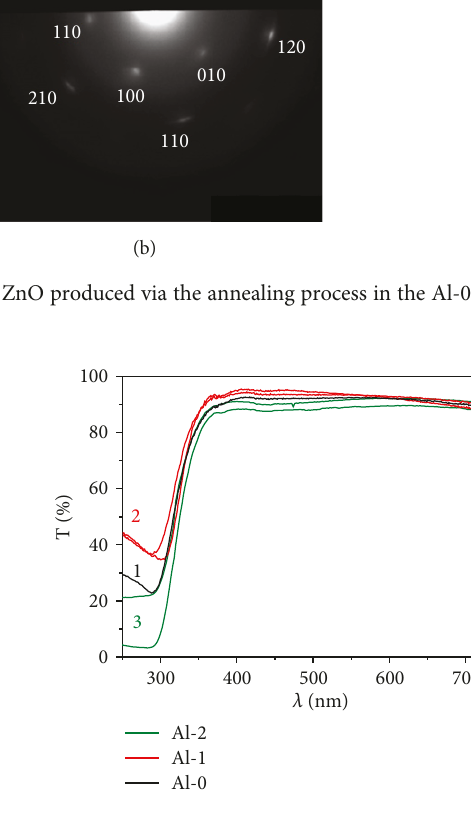
Figure 7: Optical transmittance spectra of ZnO coatings of 1 — Al-0, 2 — Al-1, and 3 — Al-2 with di ff erent thicknesses of 1000nm and 2000